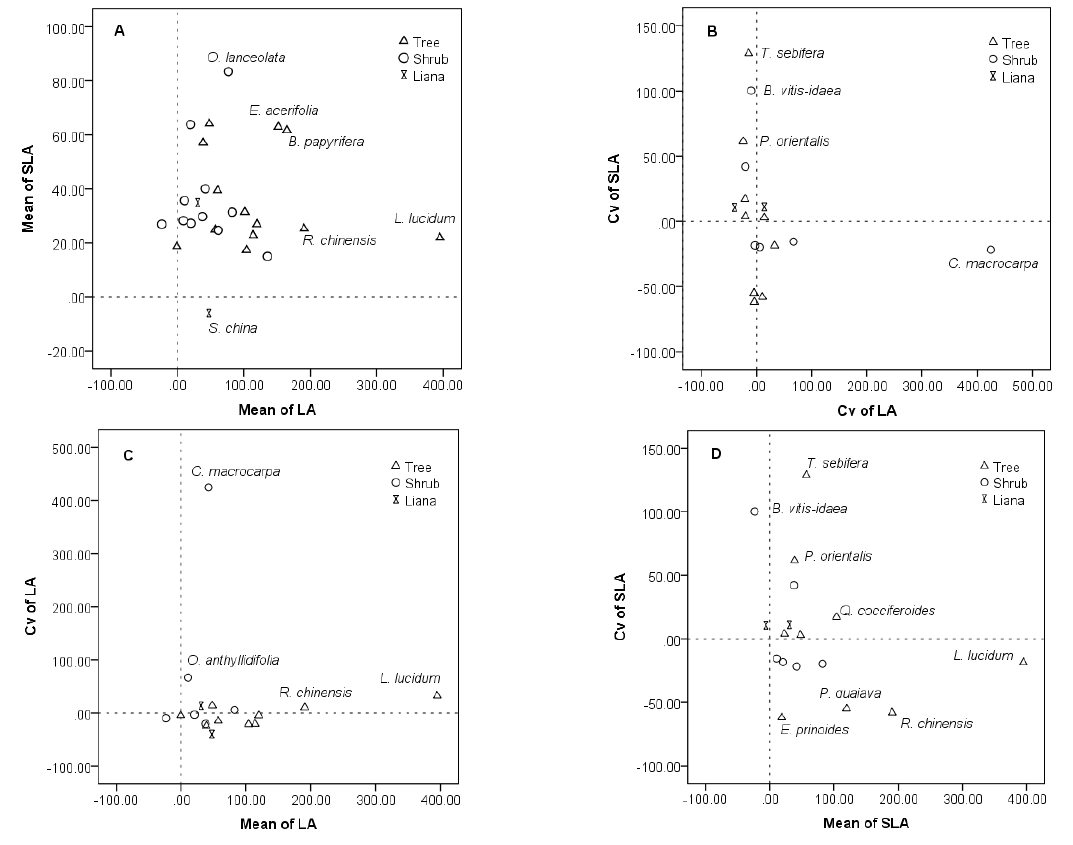
Figure 5. Change magnitude of leaf area (LA) and specific leaf area (SLA) in shading habitats compared to open habitats. All the data presented here are the percentages of changed values (mean in all the shading treatments minus the mean value in open conditions) relative to values that were obtained in open conditions. ( A , B ) show the changes in the trait mean or coefficient of variation (CV) in LA and SLA; ( C , D ) showed the changes in the mean and CV in LA or SLA.